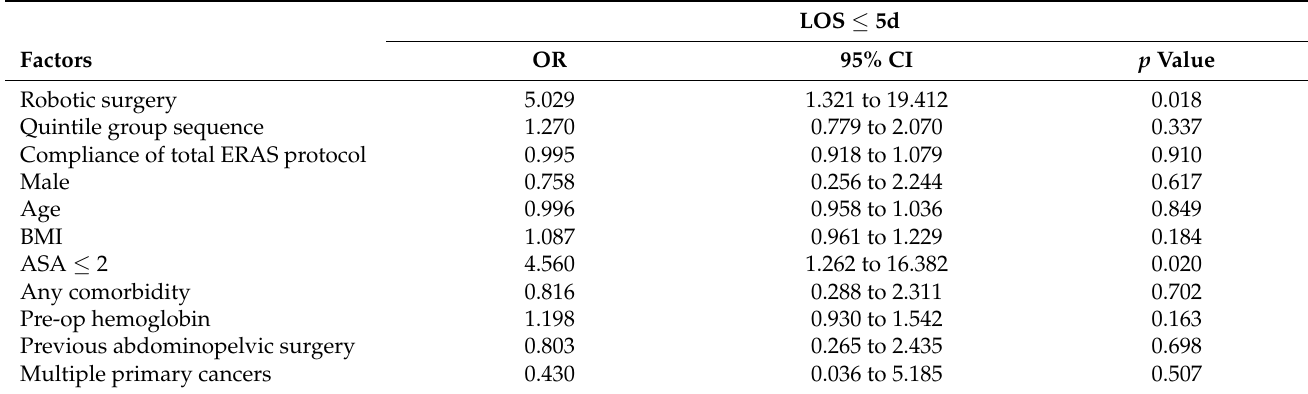
Table 7. Multivariable logistic regression model of factors associated with postoperative length of stay no more than 5 days.